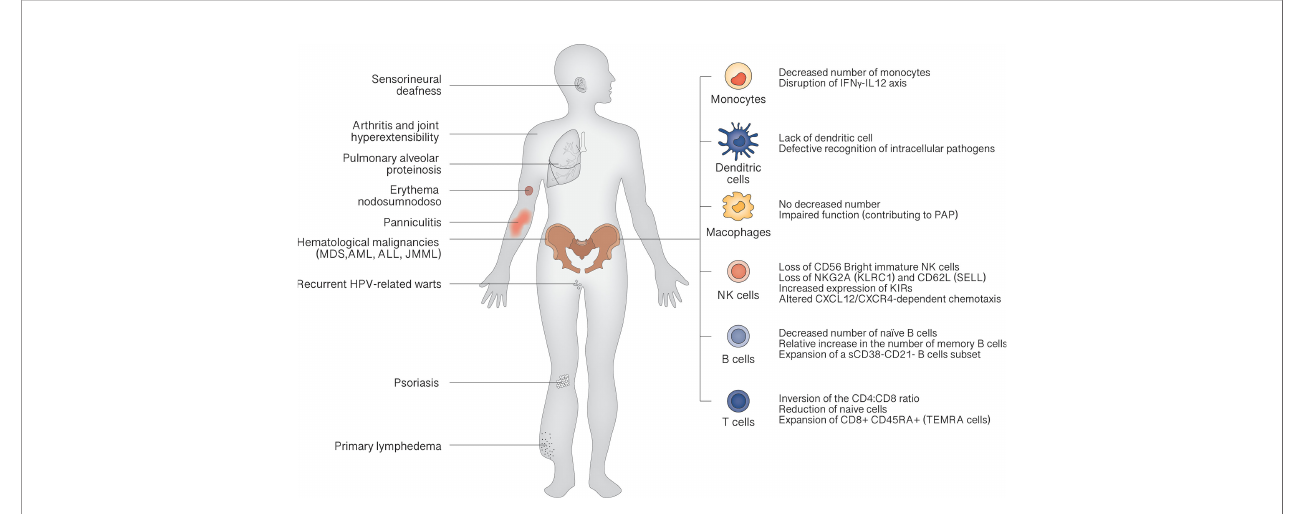
FIGURE 2 | Clinical features of GATA2 de fi